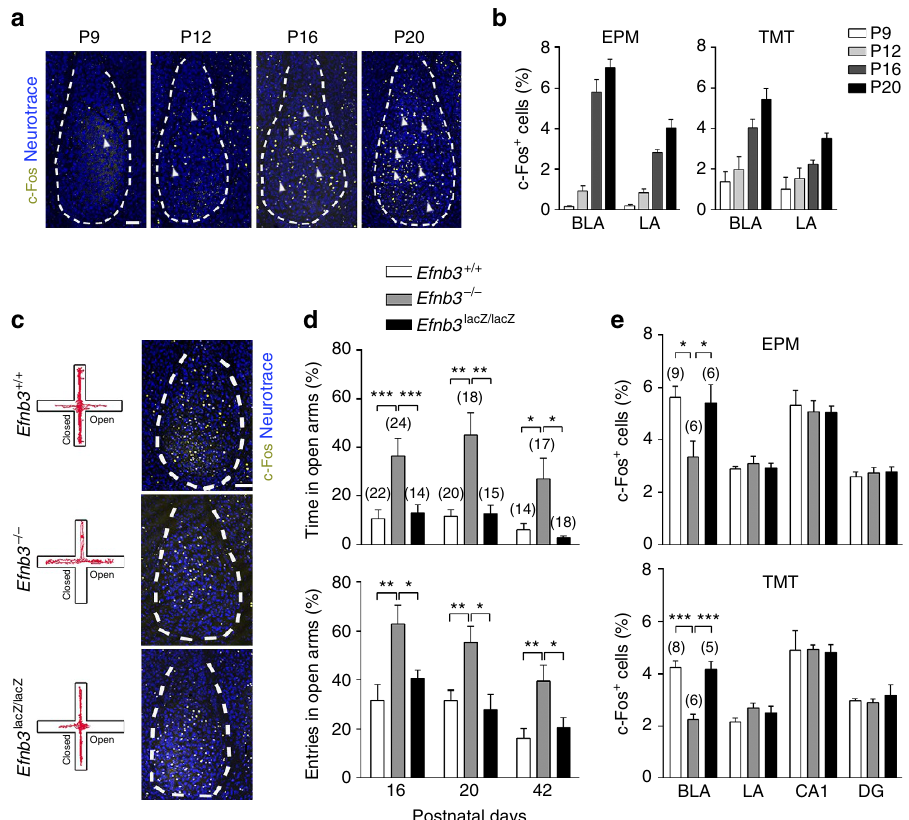
Figure 1 | eB3 is required for defensive responses and activation of neurons in the amygdala. ( a ) c-Fos expression (arrowheads indicated yellow cells) in neurons of the amygdala was markedly elicited after an EPM behavioural trial from P9 to P20. Blue: neurotrace to stain BLA cell layer at P9–P20. Scale bar, 100 m m. ( b ) Quantification of c-Fos-positive cells (percentage of total neurotrace-positive cells) in BLA or lateral amygdala (LA) from P9 to P20 following an EPM or TMT behavioural trial. n ¼ 6 mice for each group. ( c ) Representative animal track of EPM, and representative images showing the c-Fos-positive cells in amygdala of Efnb3 þ / þ , Efnb3 (cid:2) / (cid:2) and Efnb3 lacZ/lacZ mutant mice following EPM trial at P16. Scale bars, 100 m m. ( d ) Efnb3 (cid:2) / (cid:2) , but not Efnb3 lacZ/lacZ , mutant mice showed a longer time and a higher probability of open-arm entry than Efnb3 þ / þ at P16, P20 and P42. The experiments were triplicated independently. n values of mice used are indicated above group bars. * P o 0.05; ** P o 0.01; *** P o 0.001, one-way ANOVA. ( e ) Quantification of the cells with c-Fos expression at Efnb3 þ / þ , Efnb3 (cid:2) / (cid:2) and Efnb3 lacZ/lacZ mutant in BLA, LA, CA1 and DG following an EPM or TMT trial. n values of mice are indicated above group bars. * P o 0.05; *** P o 0.001, one-way